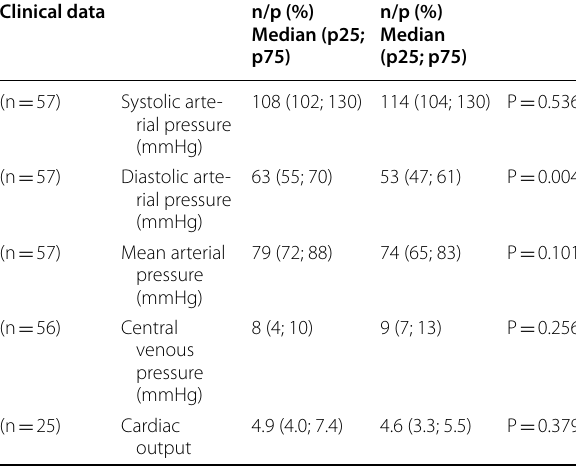
Table 1 main characteristics of the population of the study Clinical